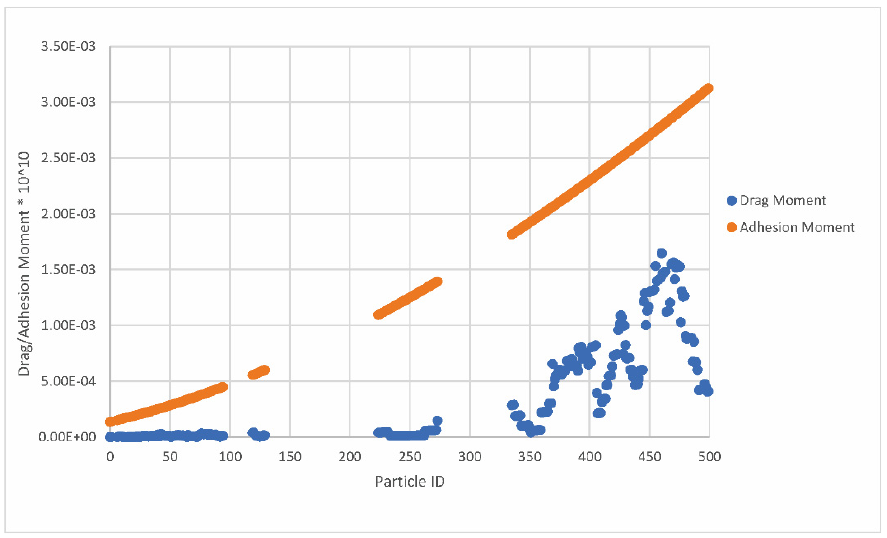
Figure 9. Relation between drag and adhesion moments for the same particle ID.